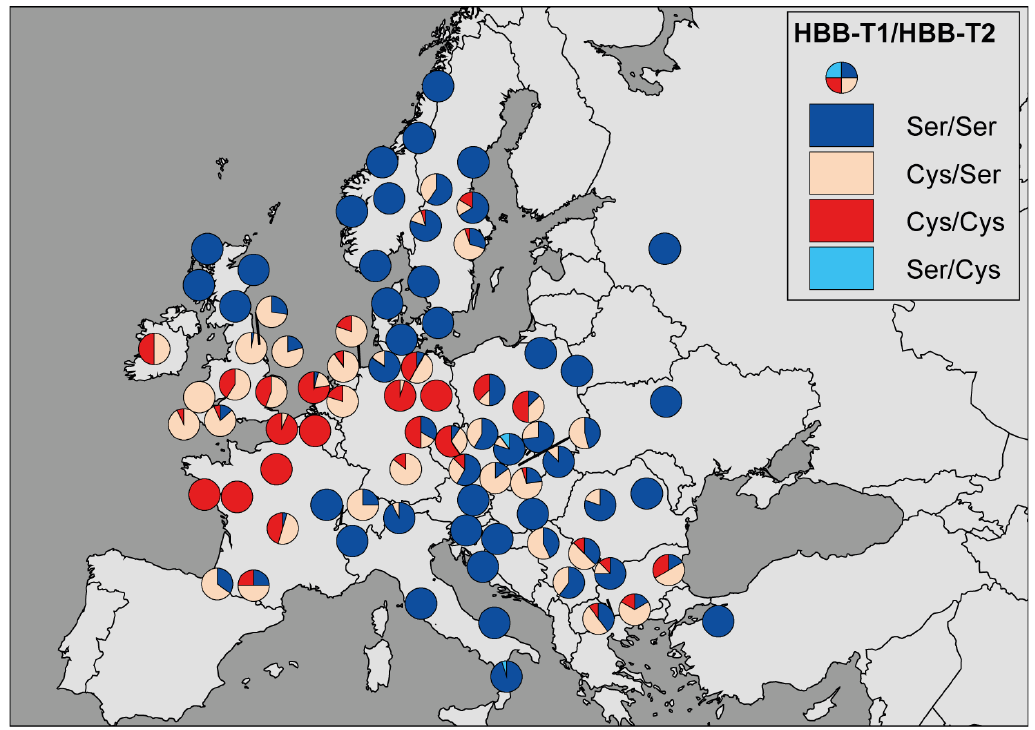
Figure 2. Geographic distribution of the two locus HBB-T1/HBB-T2 haplotypes.